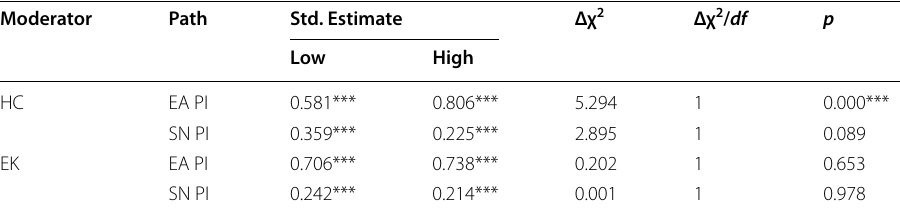
Table 5 Comparison of multi‑group SEM analysis between two HC and EK groups